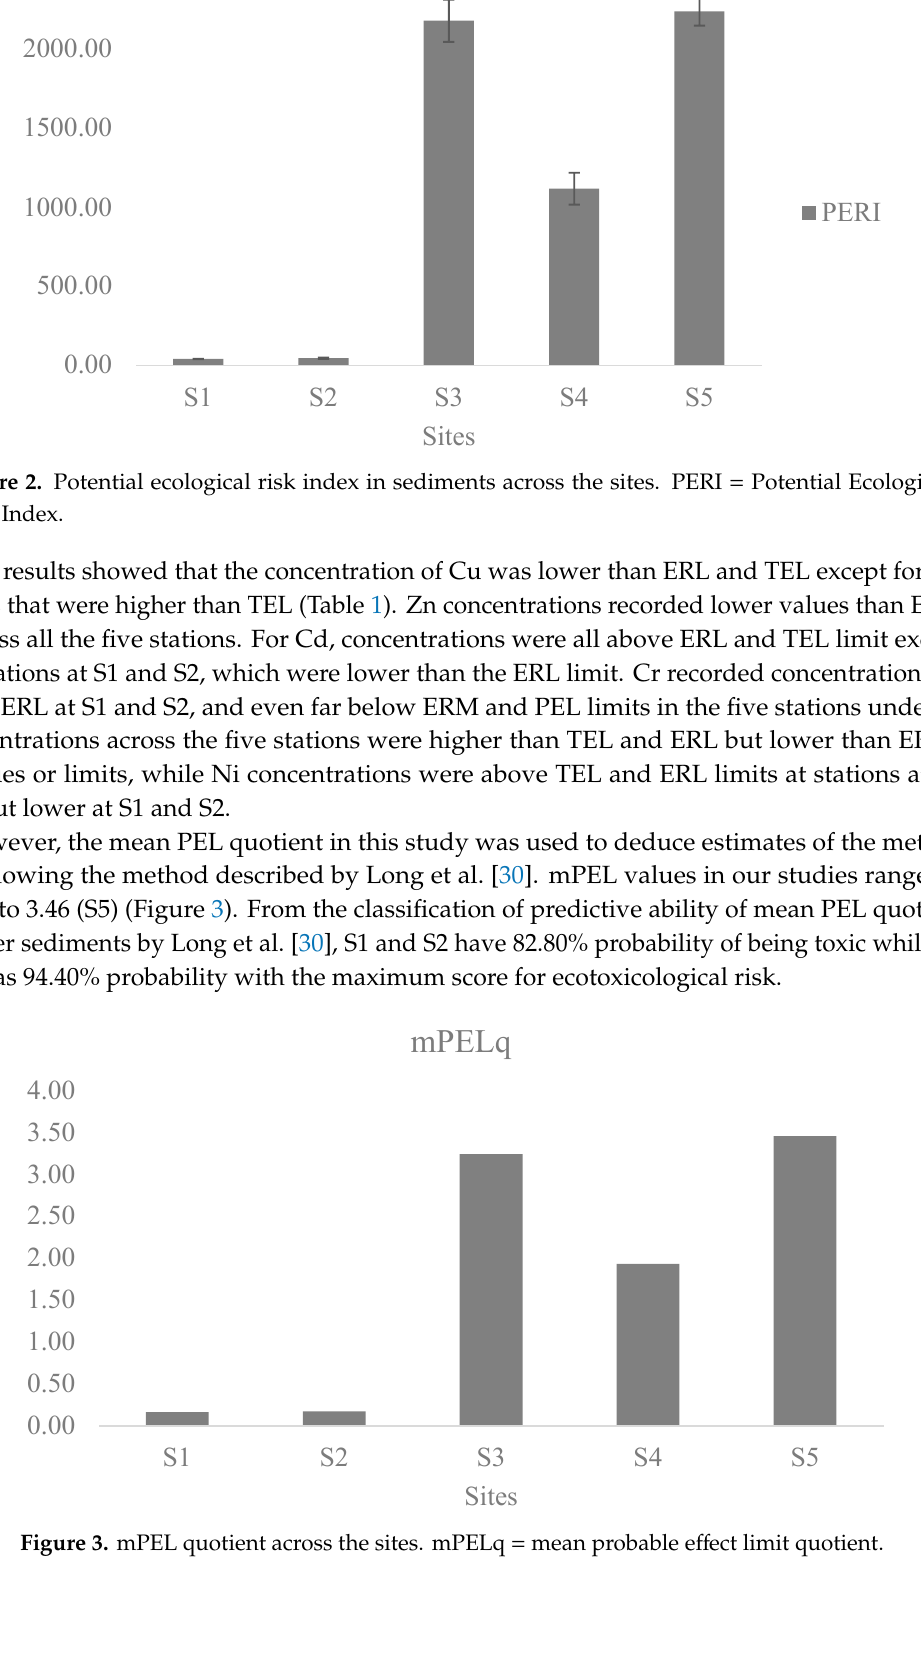
Figure 3. mPEL quotient across the sites. mPELq = mean probable e ff ect limit Figure 3. m PEL quotient across the sites. mPELq = mean probable effect limit quotient.